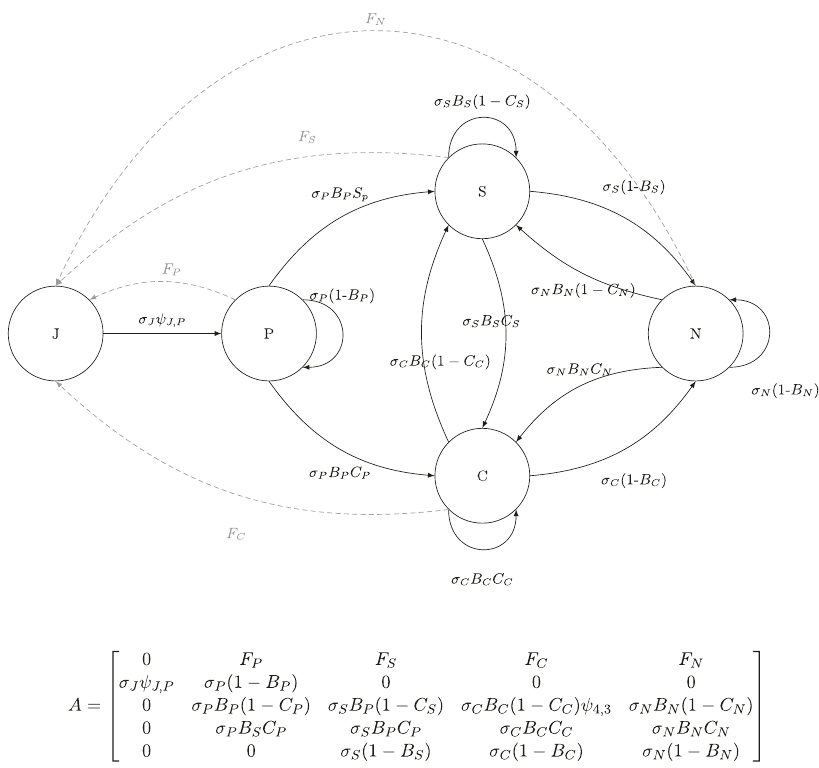
Fig. 1 Monthly life-cycle graph for female house mice. Each circle represents a life-history state, and each arc or arrow represents a transition from one state to another. Life-history states are: J = juvenile ( fi rst month of age), P = prebreeder (second month or older, not yet breeding), S = solitary breeder (female has a solitary litter), C = communal breeder (female has a communal litter), N = nonbreeder (female has no current litter, but bred previously). A post-breeding census was assumed. Survival probabilities are denoted by σ i , and transition probabilities by ψ i (conditional on survival), with B i being the probability to breed (transition towards the breeding states: B i = ψ i , S + ψ i , C ) and C i the probability to breed communally, conditional on breeding ( C i = ψ i ; C B The fertilities were given as F i and were calculated the following way, with f i being the average number of female pups produced per litter for a given state: F P = σ P B P (1 − C P ) f S + σ P B P C P f C ; F S = σ S B S (1 − C S ) f S + σ S B S C S f C ; F C = σ C B C (1 − C C ) f S + σ C B C C C f C ; F N = σ N B N (1 − C N ) f S + σ N B N C N f C . Note that females that are currently in a nonbreeding state can reproduce (and thus, have a non-zero fertility rate), because some of them will survive and reproduce before the end of the calendar month ( i.e . the end of the